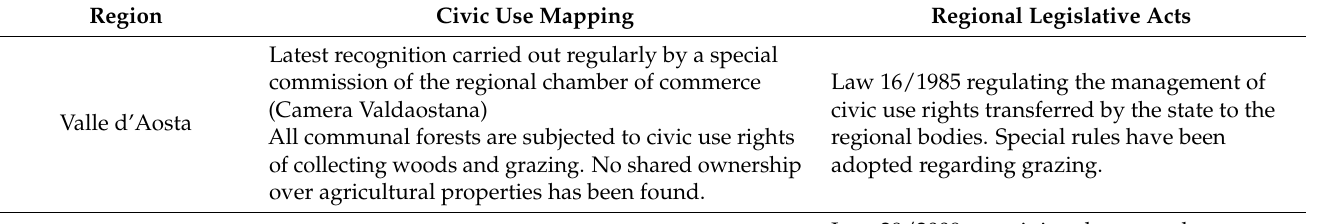
Table 2. A synthesis of the state of the art of mapping of civic use rights at the regional level and the main regional legislative acts on civic use